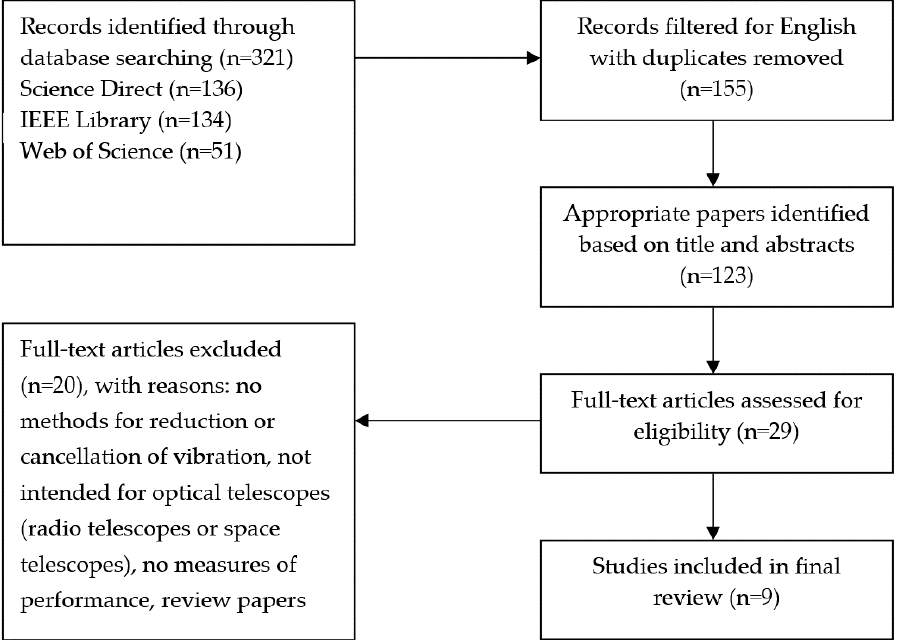
Figure 1. Consort diagram of study selection.